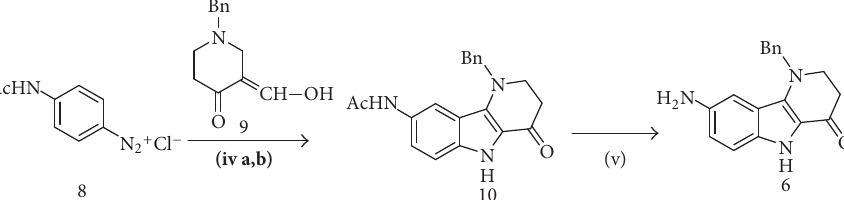
S 4: Synthesis of N-benzyl-8-amino-azacarbazole-4-one (4) (a) Japp-Klingemann-sodium acetate trihydrate, methanol, water (b) Fischer-indolization-acetic acid, HCl (5) hydrolysis, Dil.